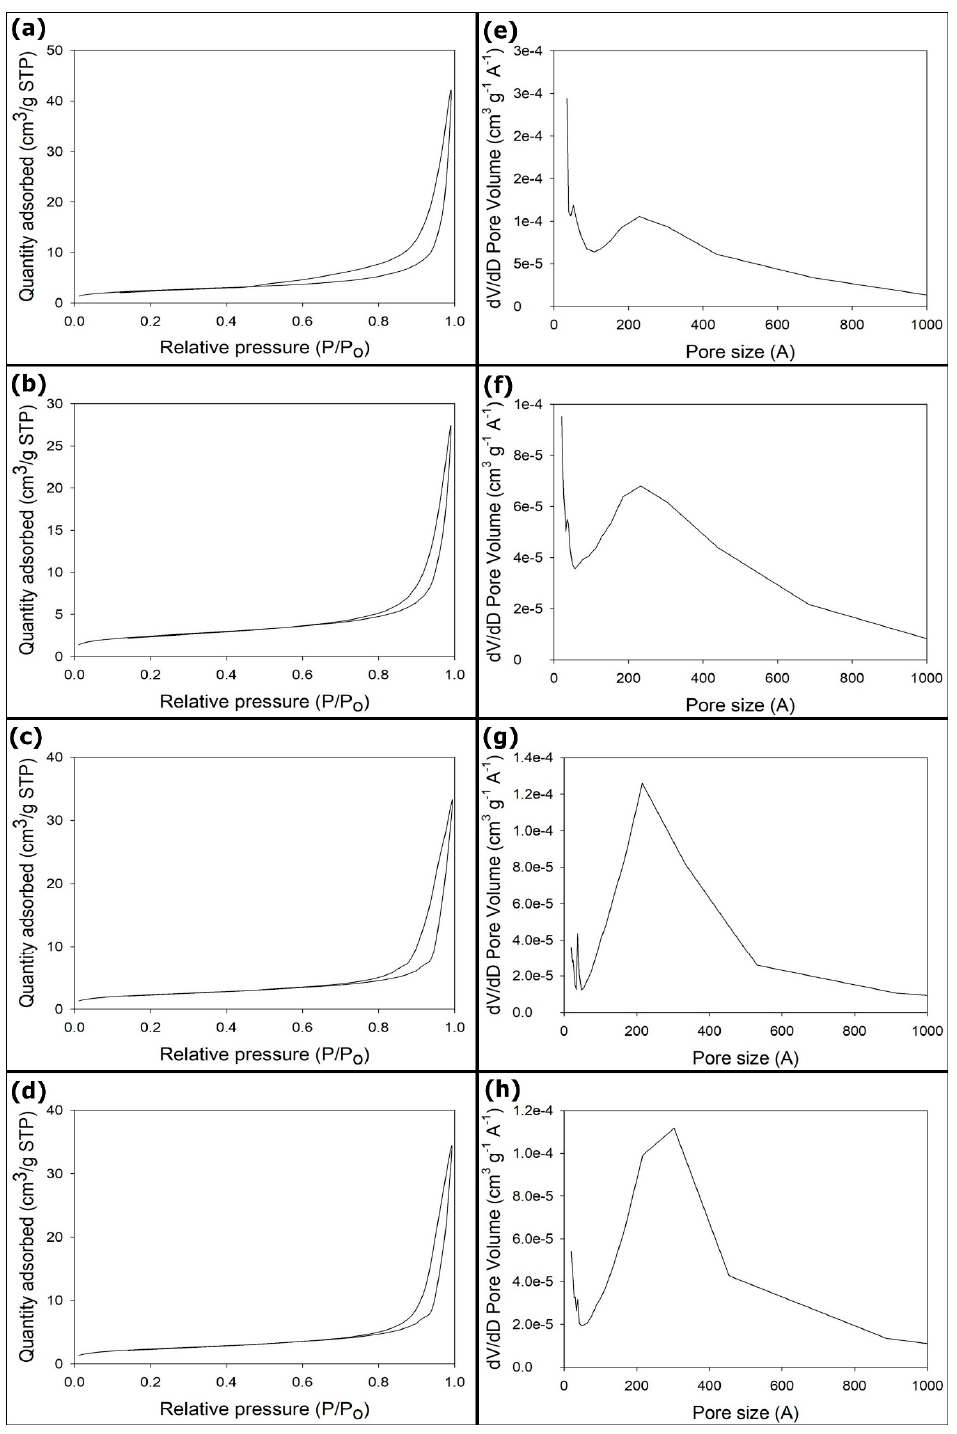
Figure 5. ( a – d ) N 2 adsorption–desorption isotherm and ( e–f ) pore size distribution curve. ( a , e